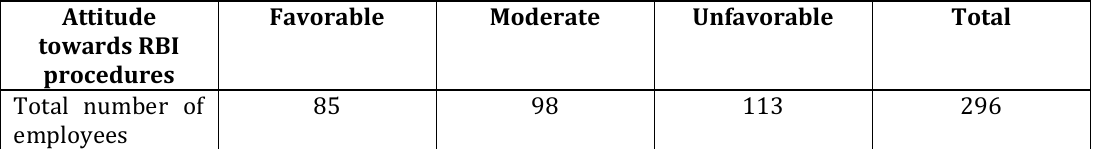
Table 6: Frequency Distribution of the Responses of Bank Employees on the basis of their Attitude towards RBI Procedures